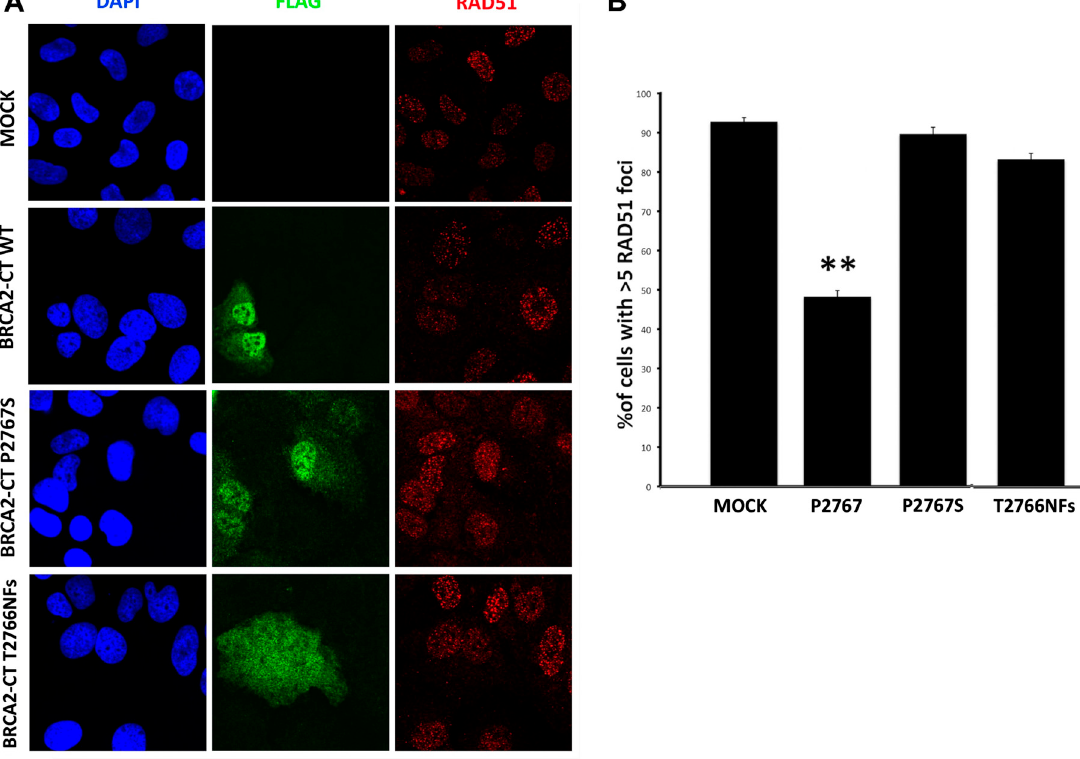
Figure 6. The analysis of the RAD51 foci formation. ( A ) The RAD51 foci formation assay upon DNA damage, 4 h post-irradiation (IR). The presence of RAD51 foci (red) in the cell nuclei shows the activation of the DNA damage repair pathway after IR. BRCA2-CT P2767S-expressing and BRCA2-CT T2766NFs-expressing cells form more RAD51 foci than BRCA2-CT wt cells do. Scale bars: 0.22 µ m. ( B ) The RAD51 foci count in the transfected cells, 4 h post-IR. The percentage of RAD51 foci on the FLAG-positive cells was significantly higher in the BRCA2-CT P2767S cells than for BRCA2-CT wt ( p ≤ 0.001) and was comparable to the mock cells ( p ≤ 0.01).